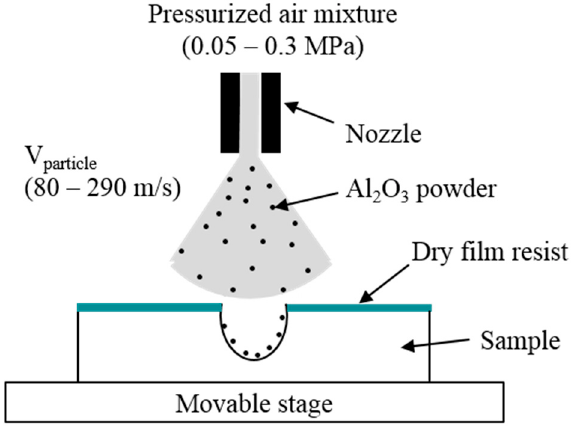
Figure 1. Sandblast setup.